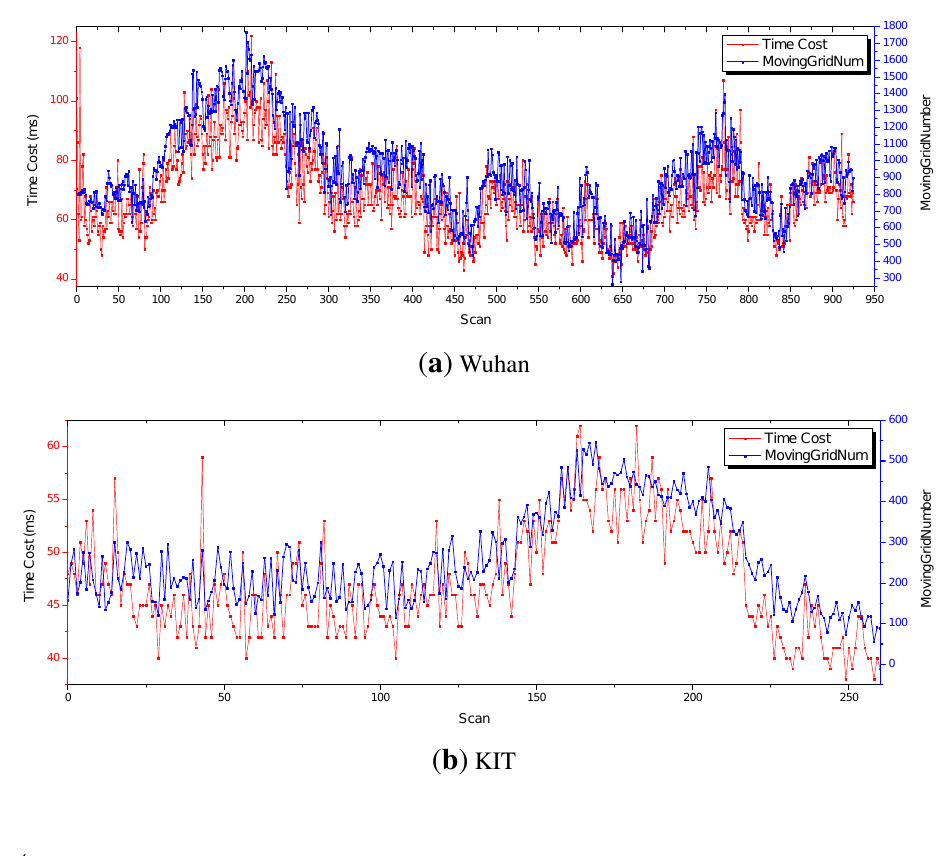
Figure 12. The relationship between time-cost and the number of moving